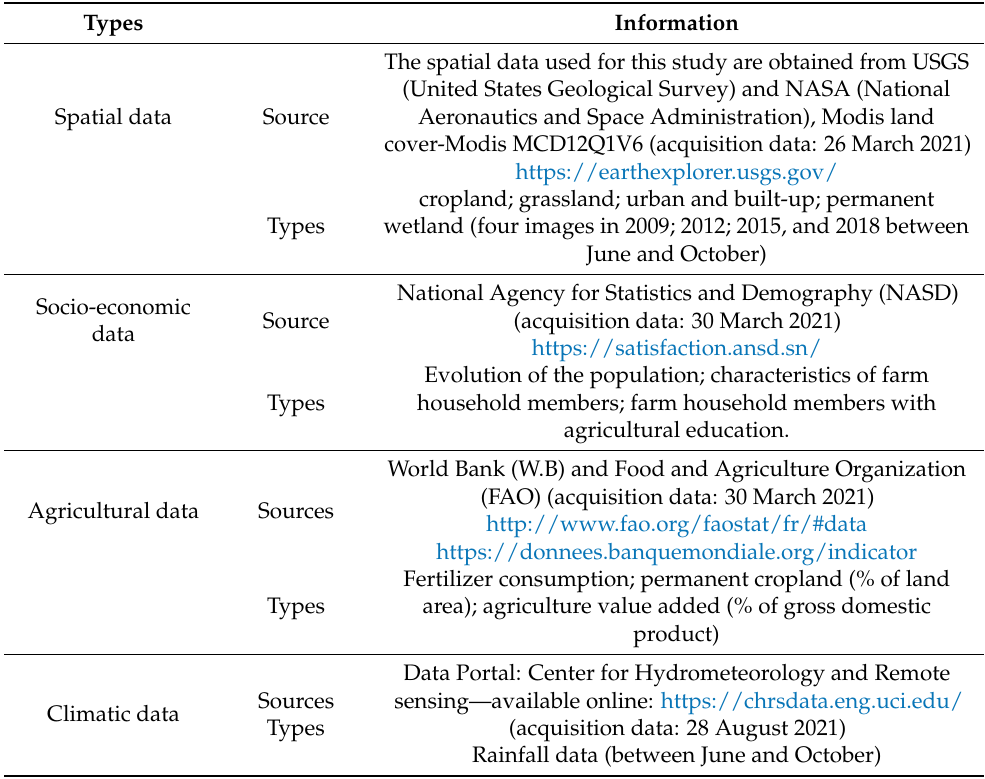
Table 1. Data sources